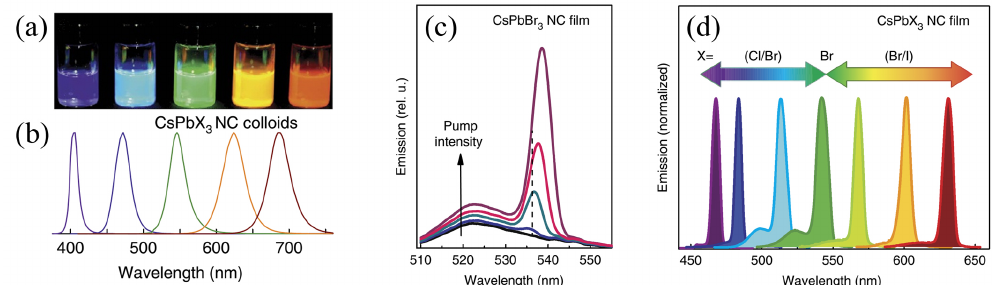
Figure 2. ( a ) Photograph of toluene dispersions of nanocrystals with four different chemical composition under UV light excitation. ( b ) PL spectra of the solutions in ( a ). ( c ) Excitation density dependence of the PL spectra of a CsPbBr 3 NCs thin film in the excitation range 3–25 µ Jcm − 2 , showing evidence of the progressive appearance of the ASE band. ( d ) Spectral tunability of ASE by compositional modulation. Adapted with permission from [5]. Nature Publishing group,